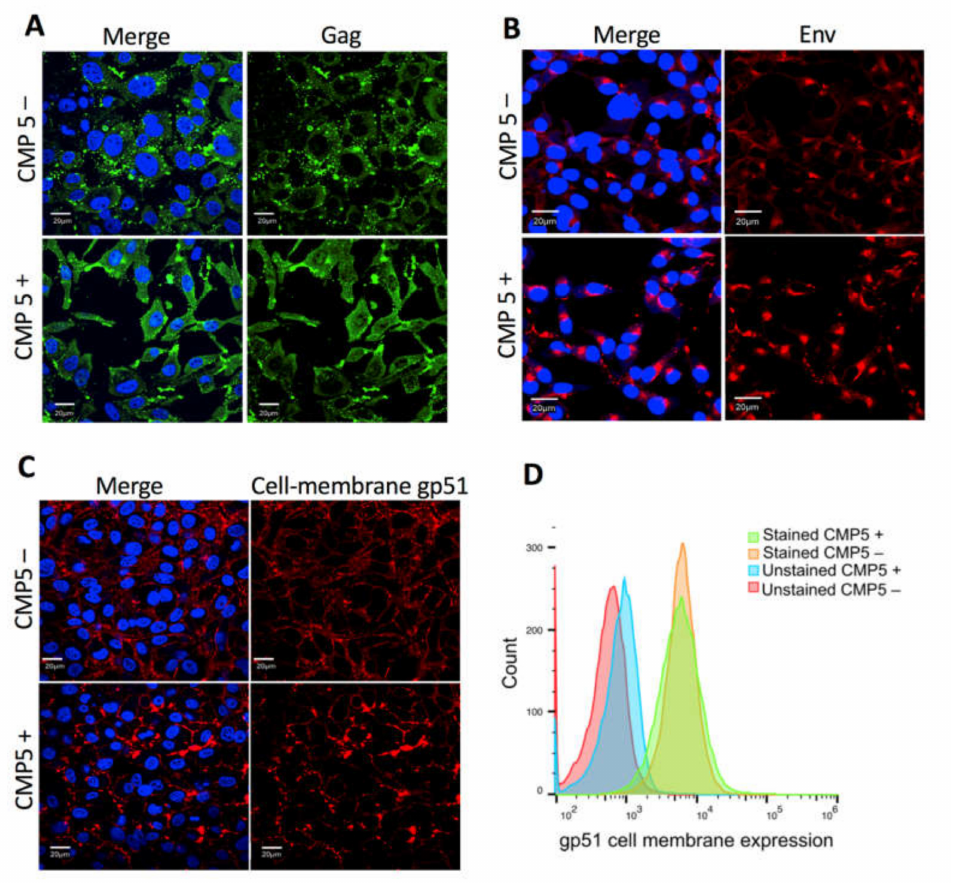
Figure 8. E ff ect of CMP5 on Gag and Env localization. ( A , B ) FLK-BLV were grown on coverslips and treated with Milli-Q water (CMP5–) or CMP5 20 µ M (CMP5 + ), Gag was stained with green fluorescence ( A ), Env was stained with red fluorescence ( B ), The cellular membrane staining of gp51 was performed without the permeabilization step ( C ). DAPI (blue fluorescence) was used to stain the nucleus and the merge picture represents Gag or Env with DAPI. The data are a representation of three